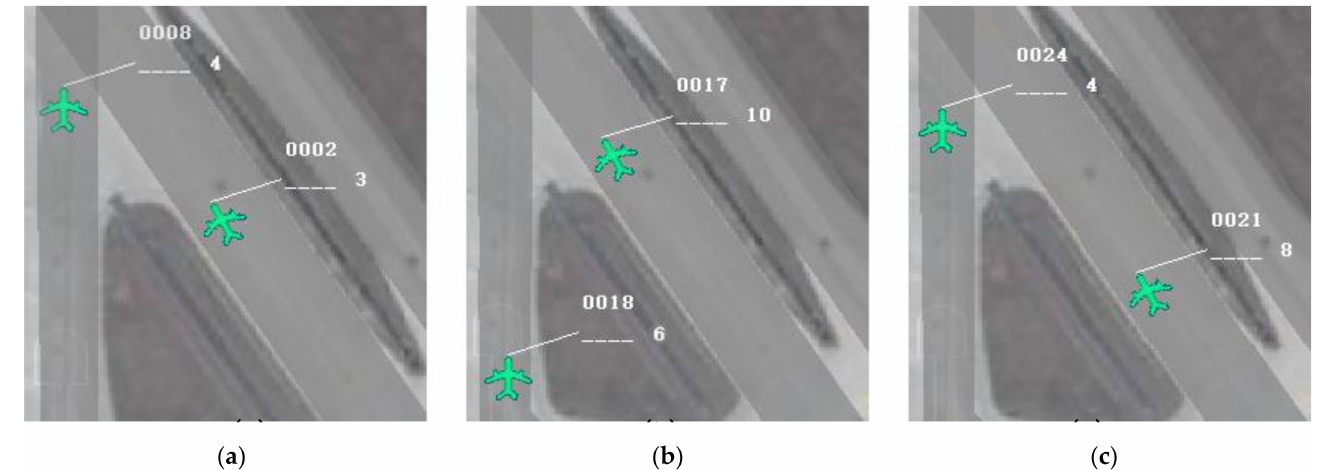
Figure 3. Schematic Diagram of Simulation Operation. ( a ) Following deceleration of the following aircraft; ( b ) Corresponding acceleration of the following aircraft; ( c ) the delayed deceleration process caused by the large separation between the two